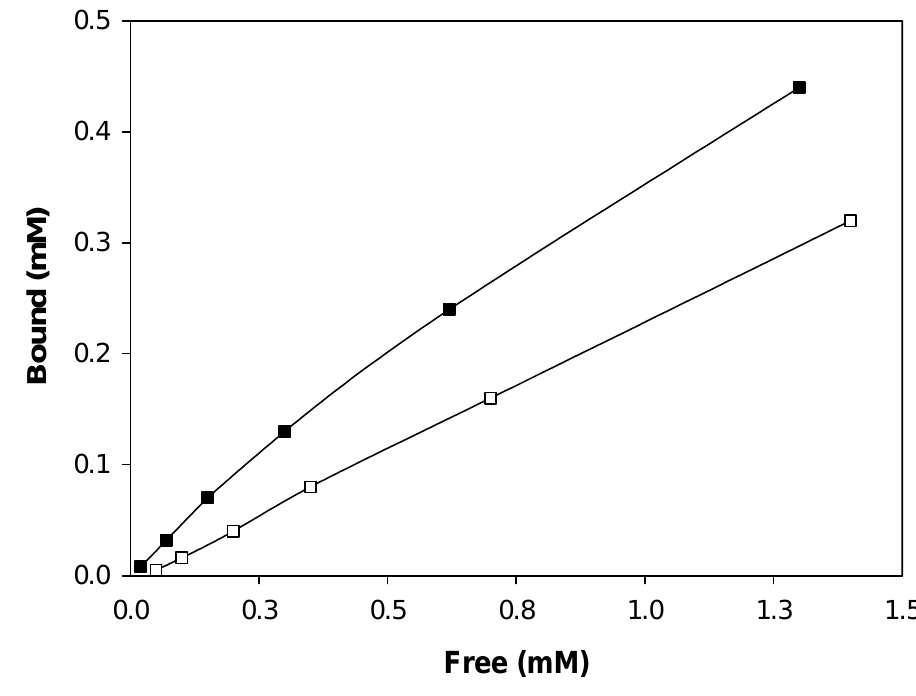
Figure 2. Binding isotherm of MIP 1b ( ■ ) and NIP 1b ( □ ) obtained by titration of the polymers with the template sulfonamide, 1 . The binding data for NIP 1b was fitted using linear regression to give the nonspecific constant ( NS ), which was subsequently fixed to calculate the apparent dissociation constant ( K ( B ) for MIP 1b using the following equation: B = F × B max